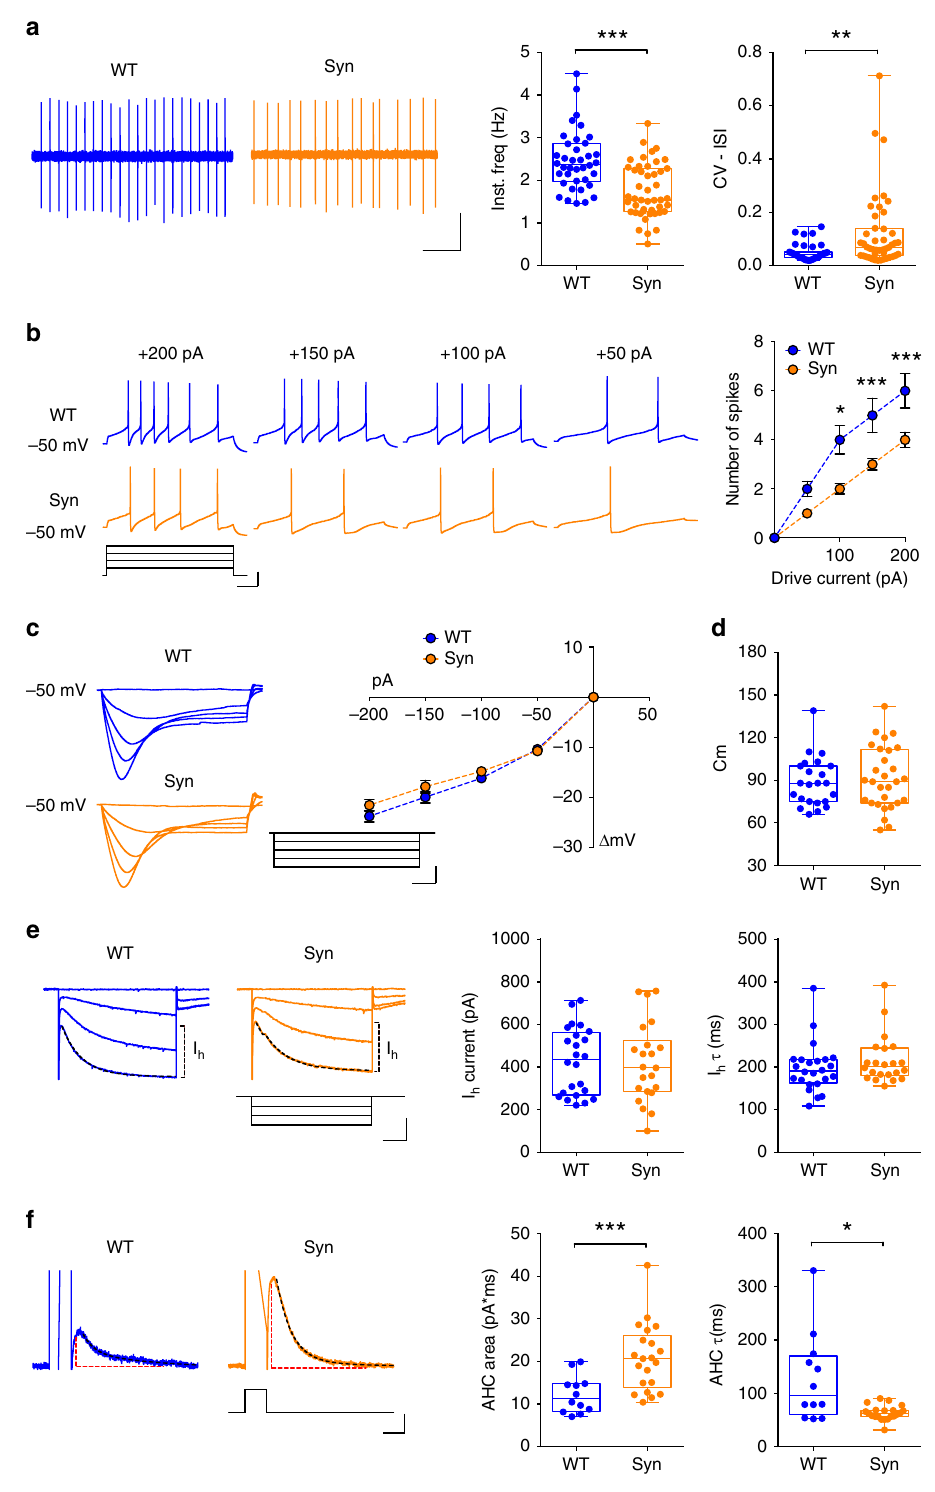
DA neurons. DA, via somatodendritic D2 autoreceptors, inhibits midbrain DA neurons by activating G-protein-coupled